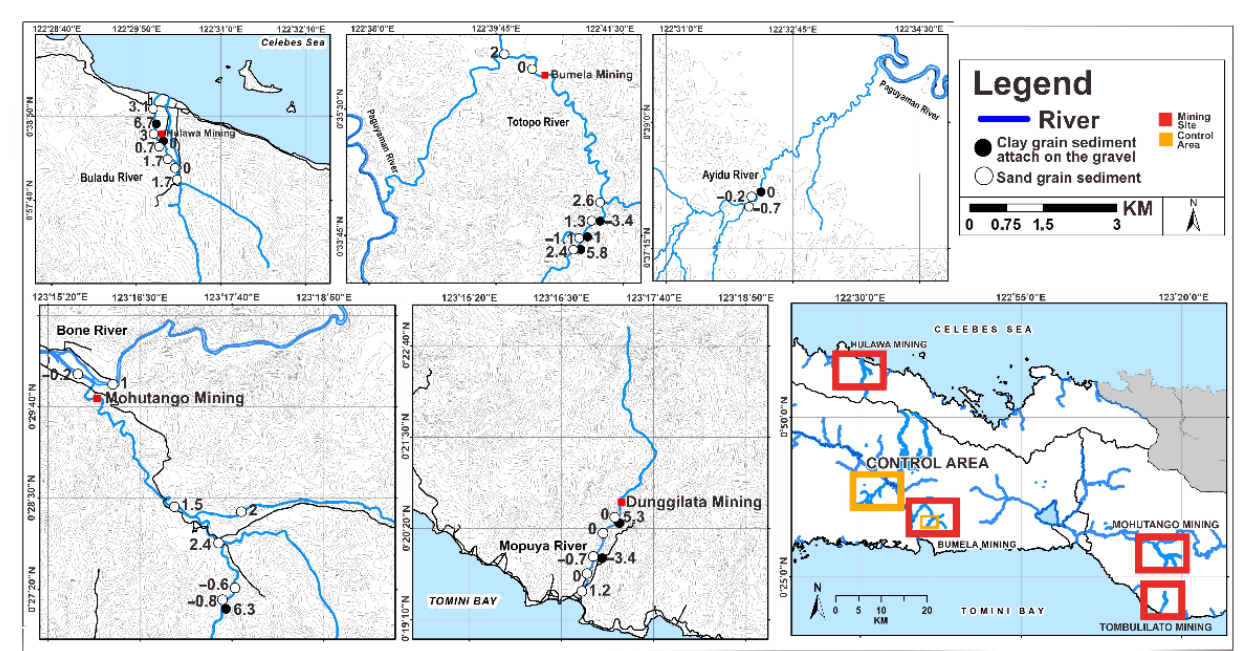
Figure 2. Plots of I geo and contaminant levels in Hg along the river sediments in Gorontalo Province, Indonesia (µg/g).